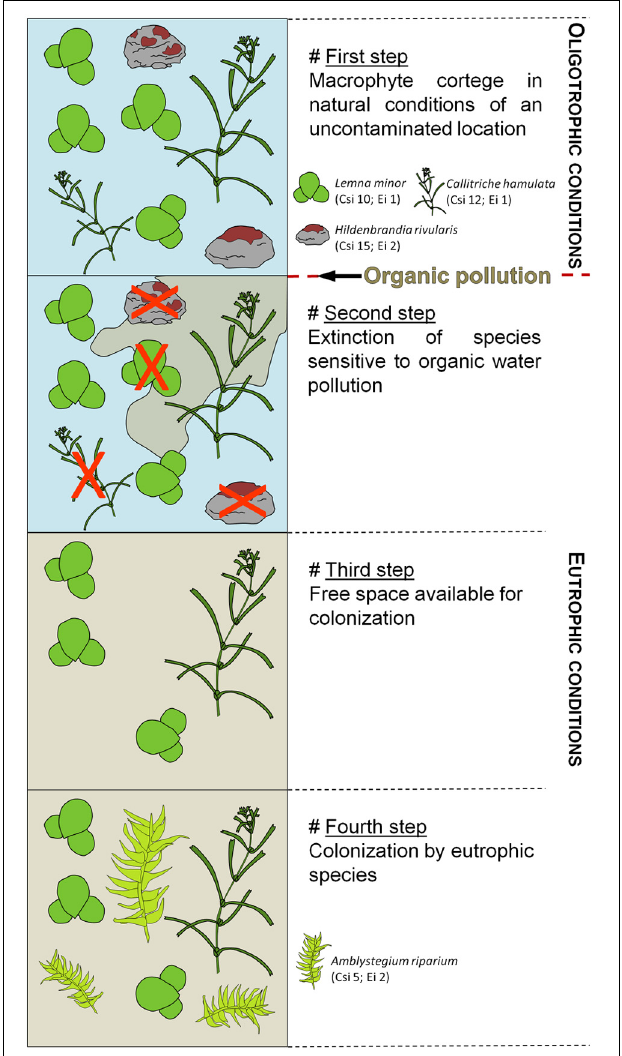
FIGURE 1 | Example of macrophyte-community dynamics in the case of eutrophication. The species presented here and their relative parameters are used in the IBMR calculation. Csi, specific trophic size (from 0 to 20); Ei, eury-stenoecie coefficient (from 1 to